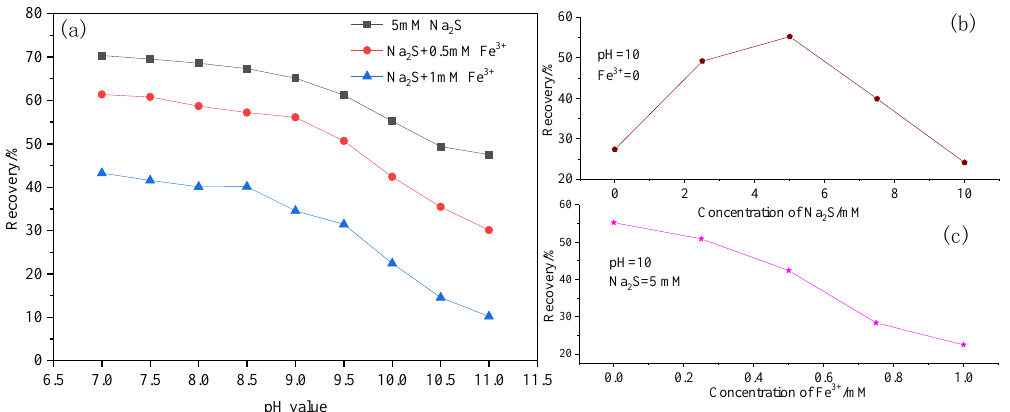
Figure 2. ( a ) Hemimorphite flotation recovery as a function of pH value in the absence and presence of Fe 3+ , ( b ) Hemimorphite flotation recovery as a function of Na 2 S without Fe 3+ , ( c ) Hemimorphite flotation recovery as a function of Fe 3+ .